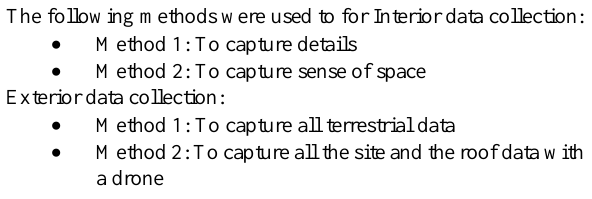
Figure 9. East Elevation, perspective data collection. Red “x” are target points. Top Left: blue square shows the first shot (notice how it captures a wider range and overlaps 1/3 rd of the grid to the right of the shot). Top Right: Pink Square is the second shot. Bottom Left: Green square is the third shot Bottom Right: 4th shot. (Drawn by Rajabzadeh, 2021)